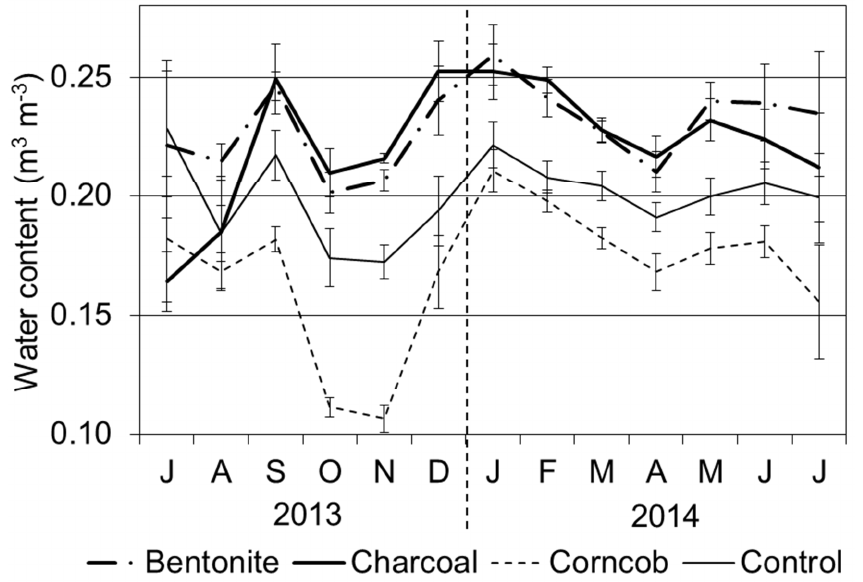
Figure 3. Average of soil water content among the four treatments before irrigation or rainfall (from July 2013 to July 2014, Mean ± SE). Note: the values of water content were averaged among several July 2013 to July 2014, Mean ˘ SE). Note: the values of water content were averaged among several dates with low values before irrigation. dates with low values before